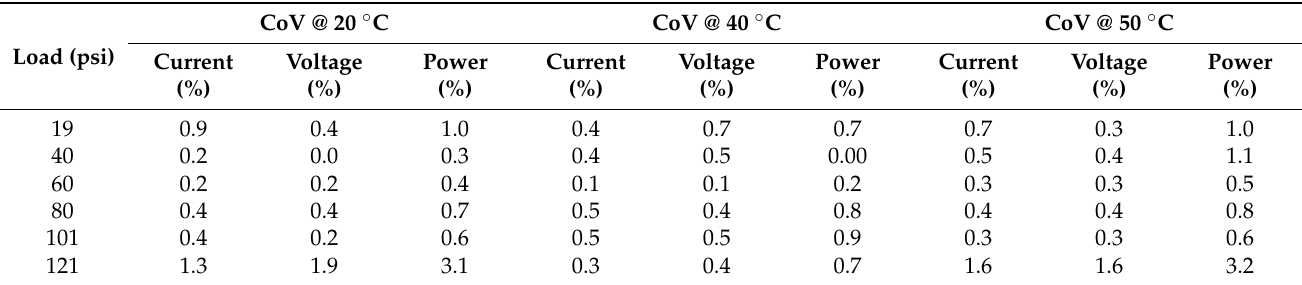
Table 2. CV Results for Type F (US